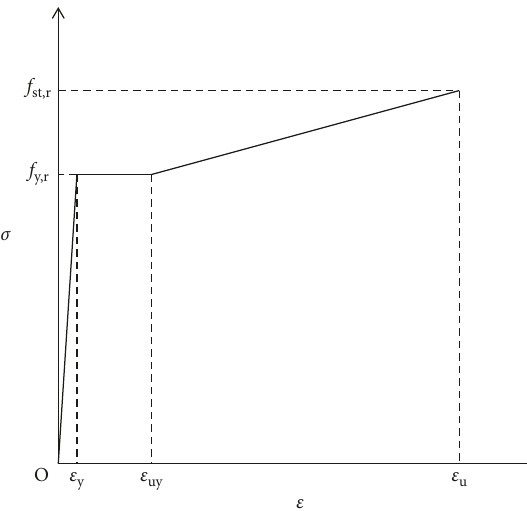
Figure 12: Stress-strain curve of hot-rolled steel.